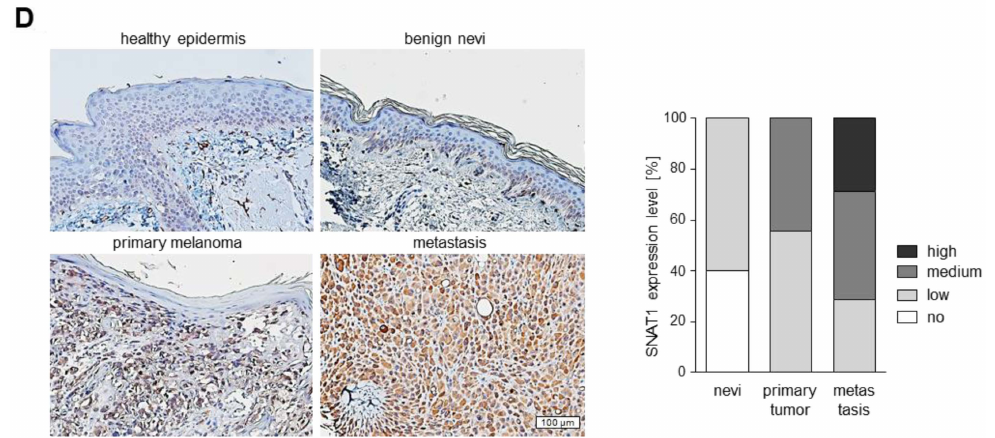
Figure 1. RNA and protein expression of SNAT1/SLC38A1 in different melanoma cell lines. ( A ) Mean expression from RNA-sequencing analysis of SNAT1/SLC38A1 mRNA in primary and metastatic melanoma cells in comparison to NHEM. Values represent the mean ± SEM of 2 independent experi- ments for NHEM and metastasis and of 6 independent experiments for primary tumor. ( B ) Confirma- tion of SNAT1/SLC38A1 mRNA expression with qRT-PCR of indicated melanoma cell lines obtained from primary and metastatic melanoma, normalized to β -actin and compared to NHEM. Values represent the mean ± SEM of at least 3 independent experiments. ( C ) Western blot analysis ( left ) and densitometric analysis ( right ) of SNAT1 protein level of indicated melanoma cell lines normalized to β -actin and compared to NHEM. The siPool-mediated SNAT1 downregulation confirmed that SNAT1 protein sizes range from 50–70 kDa in Western blot analysis, potentially due to glycosylation (Supplementary Figure S1). Values represent the mean ± SEM of at least 3 independent experiments. ( D ) Representative immunohistochemical staining of SNAT1 protein in healthy epidermis, benign nevi, primary, and metastatic melanoma tissue samples of formalin-fixed and paraffin-embedded tissue blocks ( left ). Percentage of no, low, medium, and high SNAT1 expression level in benign nevi (n = 10), primary (n = 9), and metastatic melanoma (n = 7) tissue IHC-staining ( right ). p -value < 0.05 was considered statistically significant (*). The uncropped western blot figures are presented in Supplementary Figure